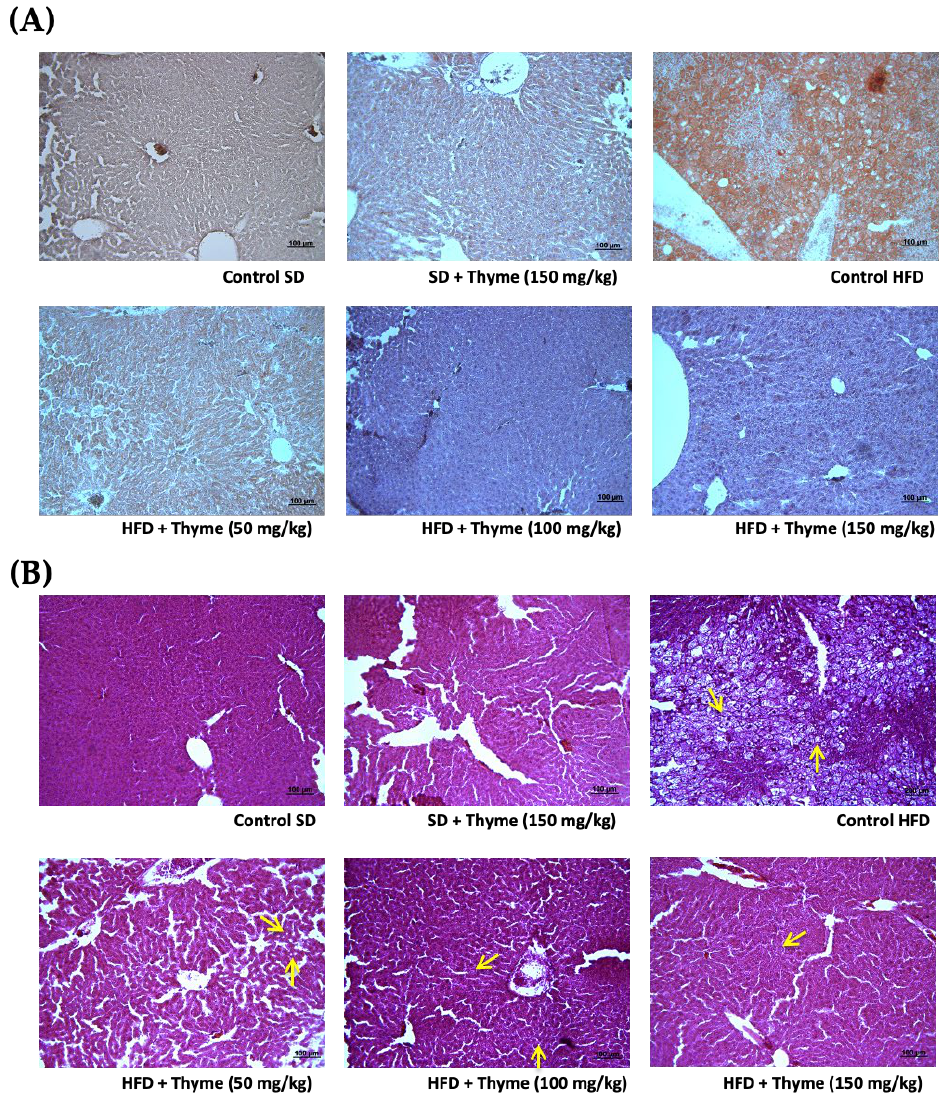
Figure 4. Effects of Thyme extract administration on fat deposits in liver tissue stained with oil red and hematoxylin ( A ) and with hematoxylin and eosin ( B ). Yellow arrows indicate the presence of lipid vacuoles in the cytoplasm of hepatocytes and red arrows show mononuclear inflammatory aggregation.